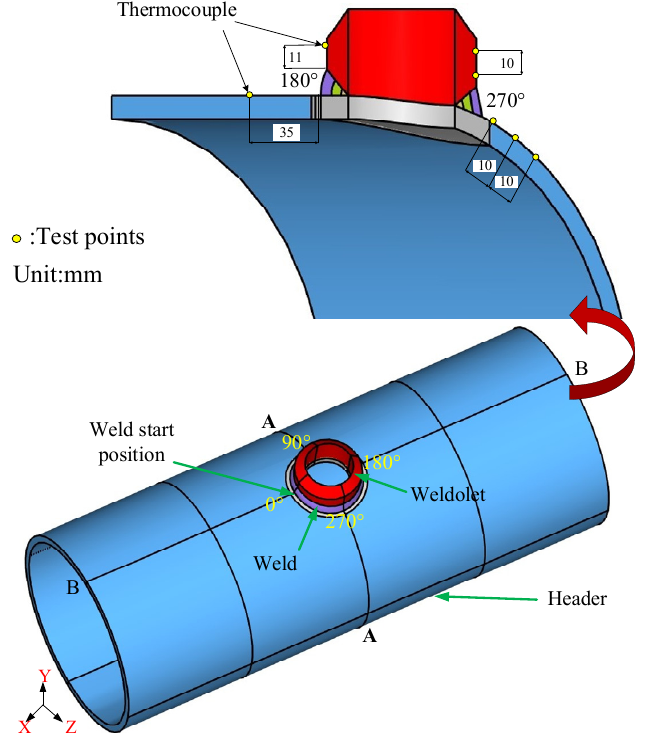
Figure 3. Three-dimensional (3D) model of header, weldolet, and welds.